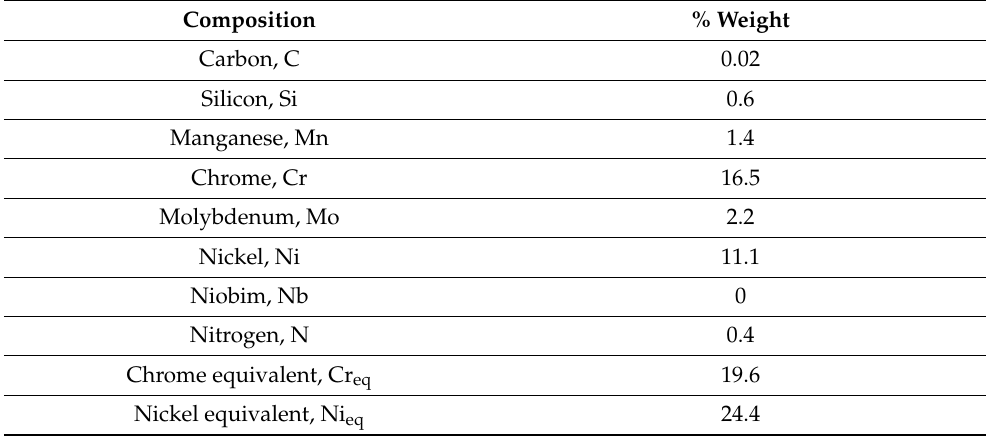
Table 2. EDS-analyzed composition (% weight) of the AISI 316 deposited layer and its corresponding Cr and Ni